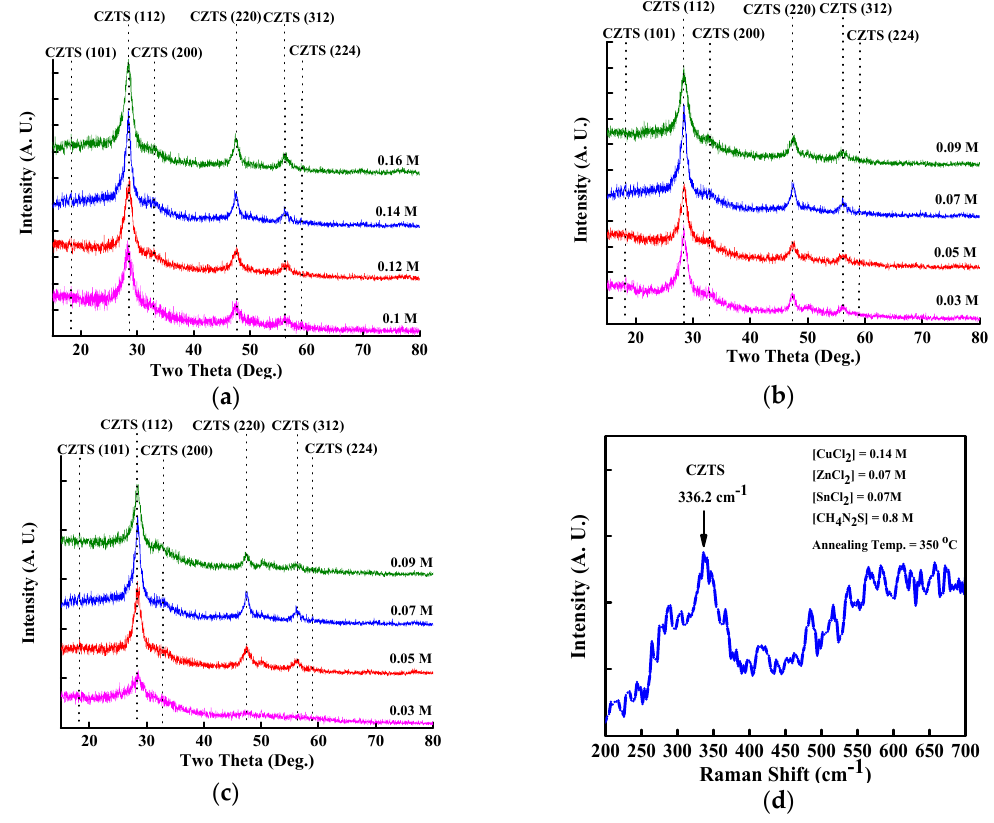
Figure 2. X-ray diffraction (XRD) patterns for CZTS thin film with varied concentration of ( a ) CuCl 2 ; ( b ) ZnCl 2 ; and ( c ) SnCl 2 aqueous precursor solution under an annealing temperature of 350 °C. The Raman spectrum for a CZTS thin film with CuCl 2 , ZnCl 2 , SnCl 2 , and thiourea aqueous precursor solution concentration of 0.14, 0.07, 0.07, and 0.8 M, respectively, after annealing at 350 °C is shown in ( d ).